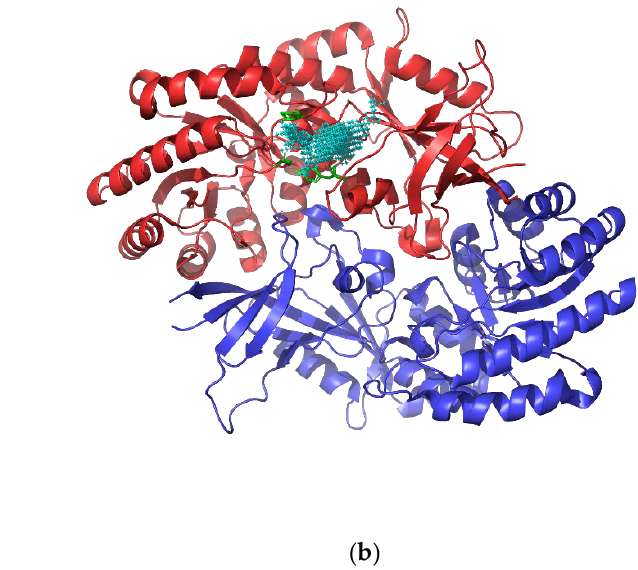
Figure 5 . Three-dimensional structures of human NUO and ODC with their binding centers. ( a ) Human NUO (5XTD) structure. Red—Subunit Q/ NDUFS2. Green—Subunit C/ NDUFS7. Blue— Subunit j/ND3. Yellow—Subunit s/ND1. Cyan—Binding site cavity; ( b ) Human ODC (2ON3) dimeric structure. Red—Chain A. Blue—Chain B. Green—Catalytic residues (Ser200, Phe238, and Tyr389) showed in sticks. Cyan—Binding site cavity.